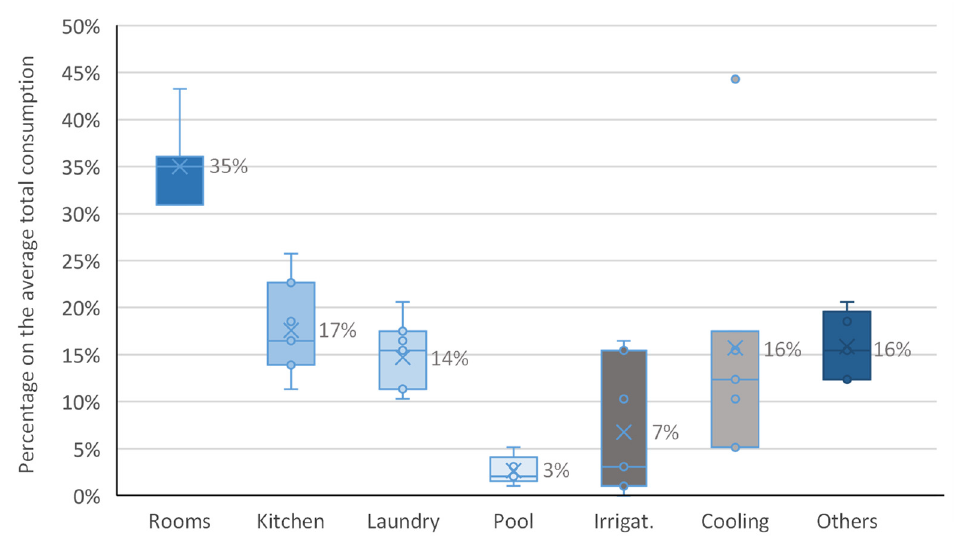
Figure 3. Contribution of each micro-component to daily water